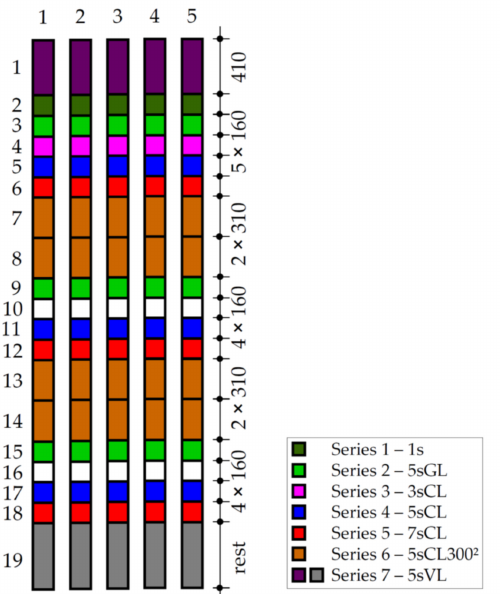
Figure 3. Assignment of board segments for specimens of different test series, exemplarily shown for five of 60 boards; for complete schema, see Jantscher [37]; lengths contain